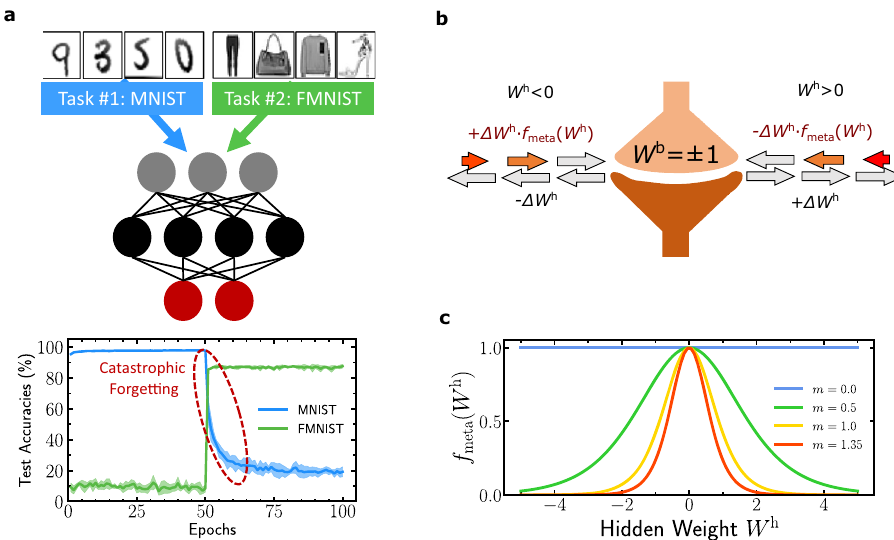
Fig. 1 Problem setting and illustration of our approach. a Problem setting: two training sets (here MNIST and Fashion-MNIST) are presented sequentially to a fully connected neural network. When learning MNIST (epochs 0 – 50), the MNIST test accuracy reaches 97%, while the Fashion-MNIST accuracy stays around 10%. When learning Fashion-MNIST (epochs 50 – 100), the associated test accuracy reaches 85% while the MNIST test accuracy collapses to ~20% in 25 epochs: this phenomenon is known as “ catastrophic forgetting. ” b Illustration of our approach: in a binarized neural network, each synapse incorporates a hidden weight W h used for learning and a binary weight W b = sign( W h ) used for inference. Our method, inspired by neuroscience works in the literature 6 , amounts to regarding hidden weights as metaplastic states that can encode memory across tasks and thereby alleviate forgetting. With regards to the conventional training technique of binarized neural network, it consists in modulating some hidden weight updates by a function f meta ( W h ) whose shape is indicated in c . This modulation is applied to negative updates of positive hidden weights, and to positive updates of negative hidden weights. f meta ( ∣ W h ∣ ) being a decreasing function, this modulation makes the hidden weight signs less likely to switch back when they grow in absolute